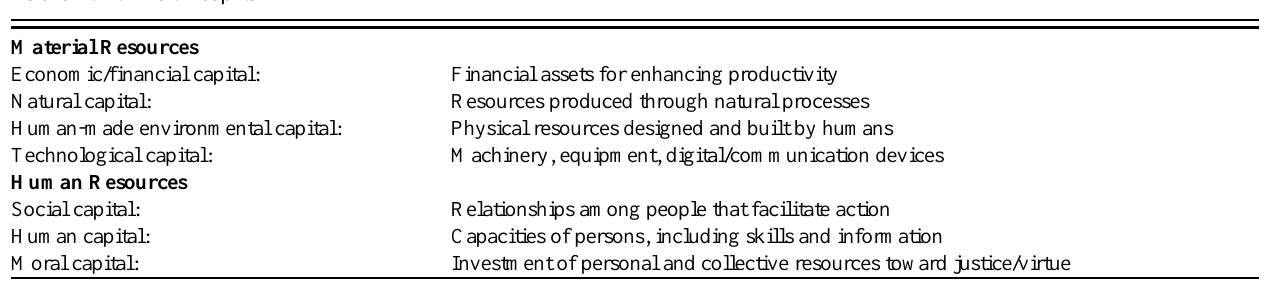
Table 1 . Forms of